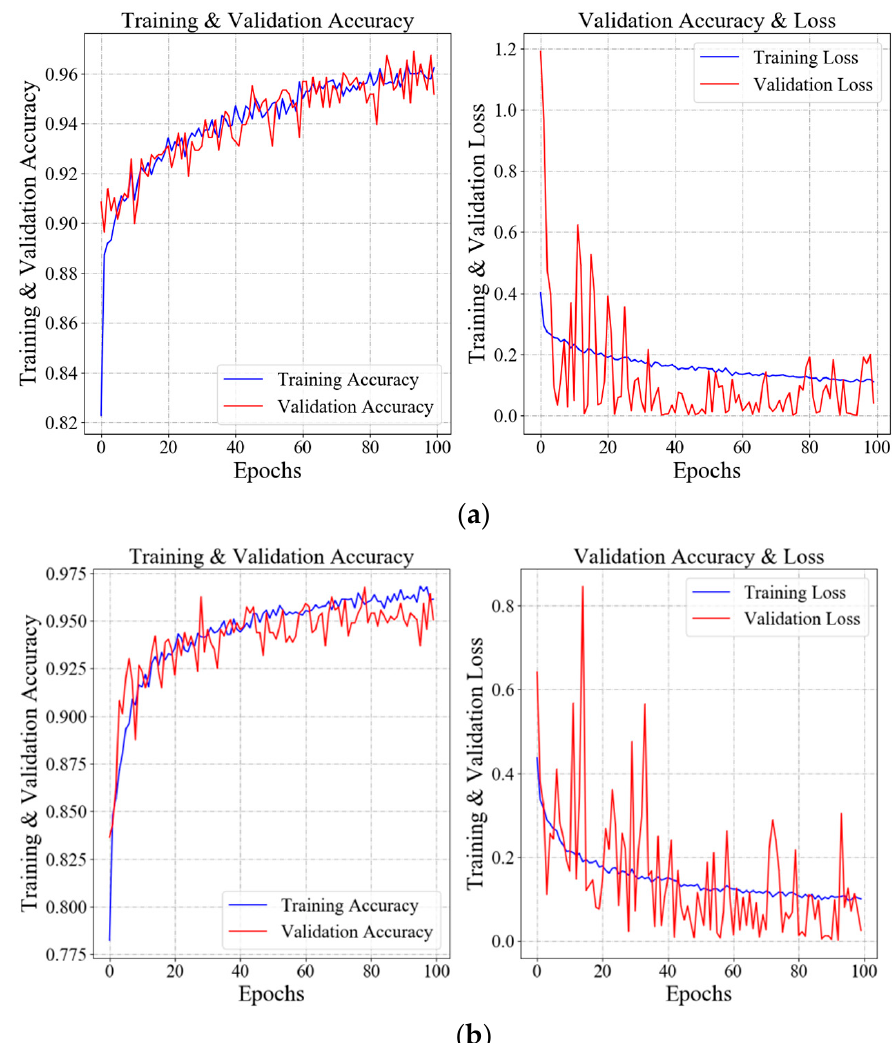
Figure 6. Training procedure. ( a ) Accuracy and loss in training process of enhanced model with our proposed model and BCE loss function using enhanced images; ( b ) Accuracy and loss in training process of the original model with our proposed model and BCE loss using original images.